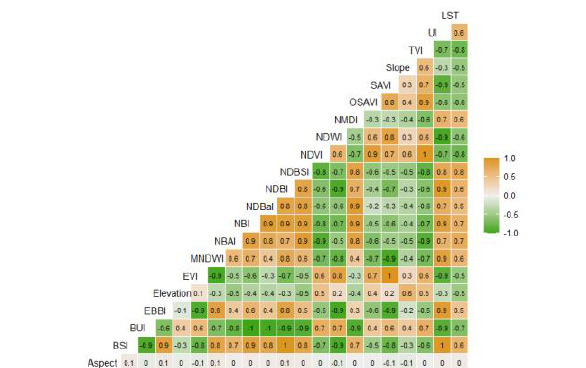
Figure 4 . Correlation matrix of the LST and the LULC indices The variables that are highly correlated, whether positively or negatively, are shown to be important for the prediction of the LST by Boruta algorithm (Figure 5). With the exception of the aspect, which is due to